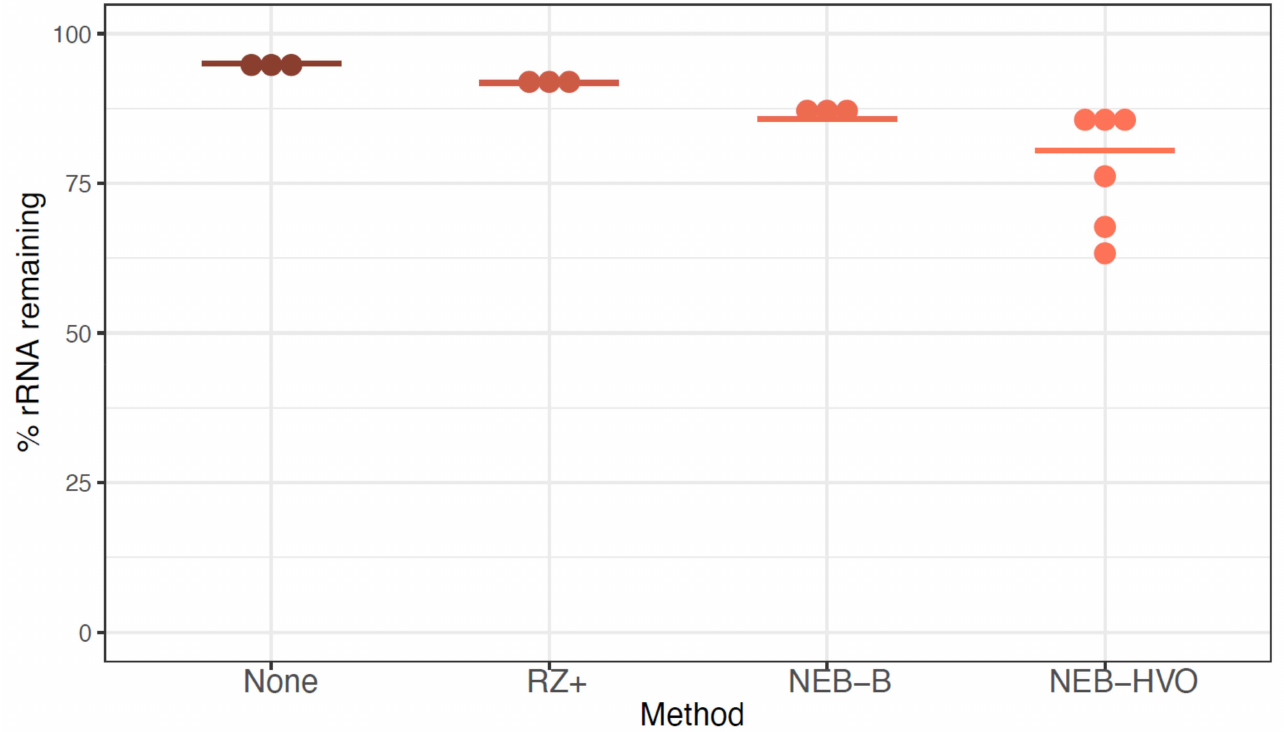
Figure 3. rRNA removal using alternative methods in Hbt salinarum . Each dot represents the percentage of counts mapping to rRNA genes after using no removal (brown), New Ribozero kit (RZ+, dark orange), NEBNext kit with bacterial probes (NEB-B, orange), and NEBNext kit with HVO probes (NEB-HVO, peach). Horizontal bars represent the median